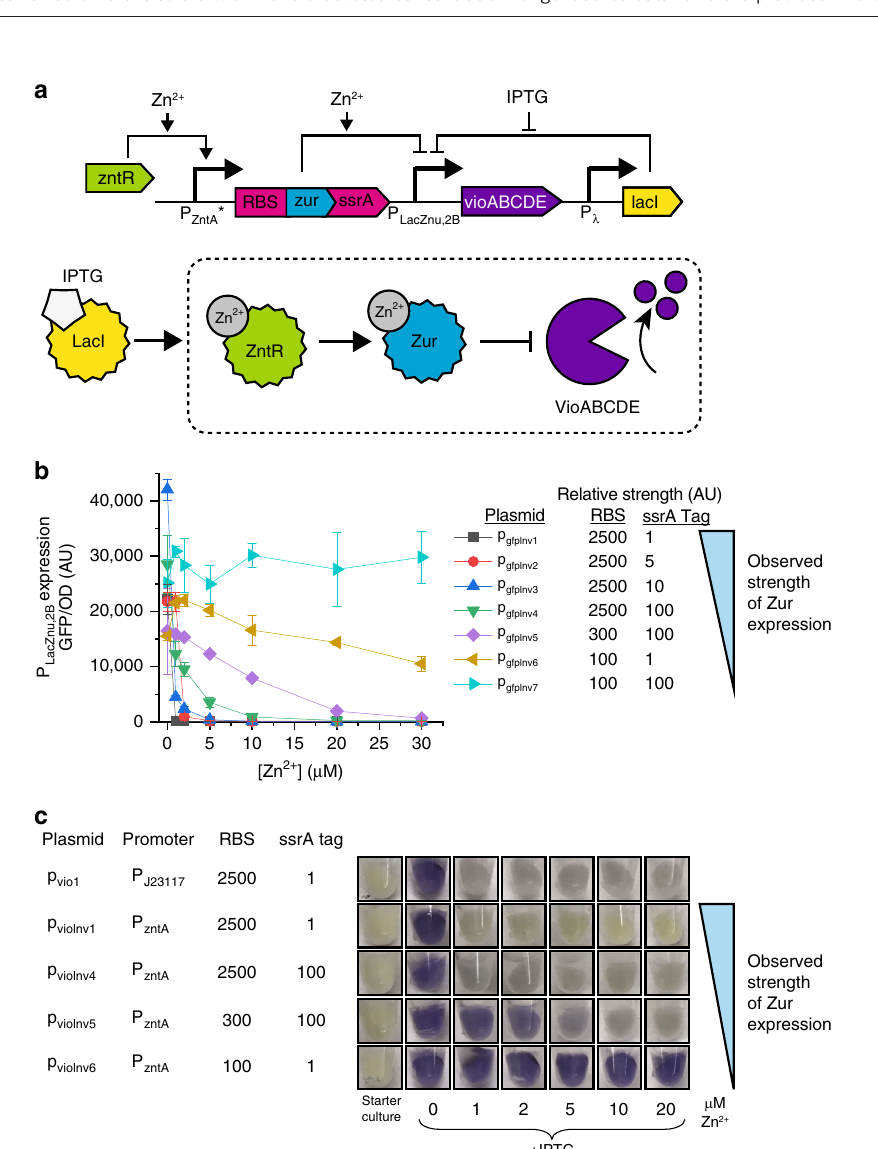
Fig. 2 Initial multi-color sensor cells. a Circuit diagram and schematic depicting the design of the three-color circuit. During the pre-assay culture stage, LacI represses all pigment production by repressing P LacZnu,2B (which controls violacein production) and P Lac (which controls lycopene production). IPTG alleviates LacI repression, activating the pigment production module indicated by the dashed box in the schematic. The crtEBI genes, which control lycopene production, are produced at all zinc concentrations. In low zinc concentrations, violacein is produced, overpowering lycopene production and leading to visibly purple cells. At intermediate zinc concentrations, Zur binds zinc and represses violacein expression, leading to visibly red cells. At high zinc concentrations, ZntR also binds zinc and activates production of CrtY, which converts lycopene to β -carotene, leading to visibly orange cells. b Pigment quanti fi cation and visualization of sensor cells that were induced with IPTG and grown for four hours. At low zinc concentrations, cells produce violacein and lycopene and appear visibly purple. Cells grown in zinc concentrations between 0.2 and 10 µ M are visibly red. At high zinc concentrations, β -carotene production overpowers lycopene production, and cells appear visibly orange. The dotted line indicates the threshold for visible violacein. Error bars indicate standard deviations. The bracket indicates the range of physiologically relevant zinc concentrations corresponding with cells grown in 25% human serum. Ideally, cells should appear three different colors within this bracketed concentration range. Source data for b are provided in the Source Data fi le.